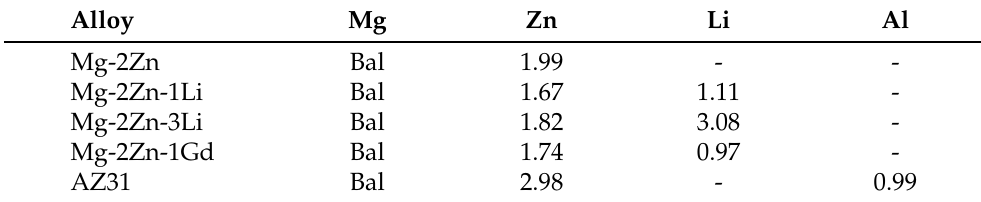
Table 1. Chemical compositions of the as-cast alloys (wt%). Alloy Mg Zn Mg-2Zn